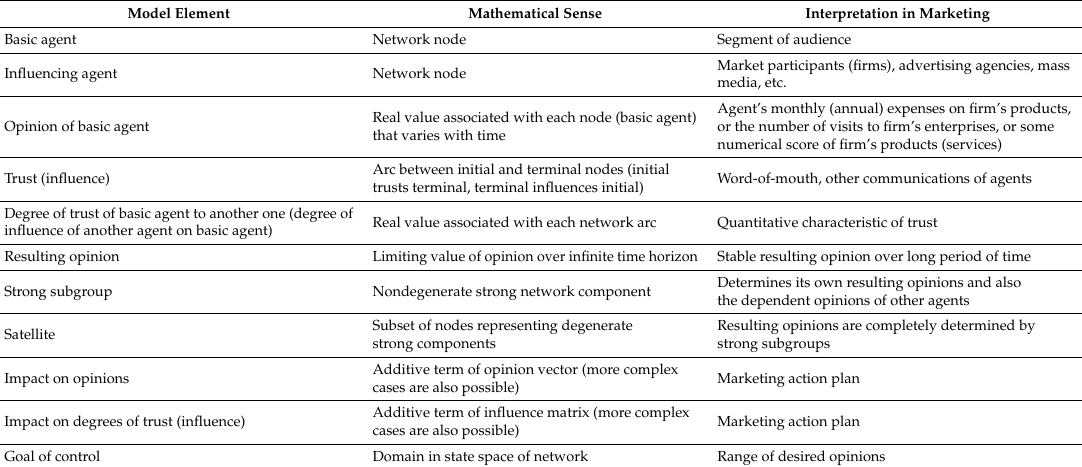
Table 1. Interpretation of di ff erent elements of the models of influence and control on networks in